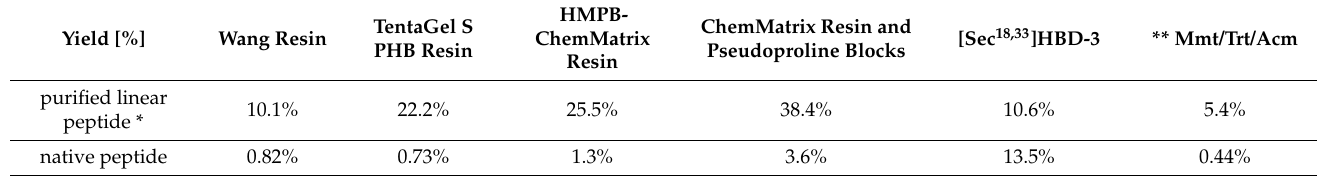
Figure 2. RP-HPLC traces of crude, linear precursor of HBD-3 synthesized on various resins: Figure 2. RP ‐ HPLC traces of crude, linear precursor of HBD ‐ 3 synthesized on various resins: ( A ) ( A ) HBD-3 synthesized on Fmoc-Lys(Boc)-TentaGel S PHB resin; ( B ) HBD-3 synthesized on Fmoc- HBD ‐ 3 synthesized on Fmoc ‐ Lys(Boc) ‐ TentaGel S PHB resin; ( B ) HBD ‐ 3 synthesized on Fmoc ‐ Lys(Boc)-Wang resin; ( C ) HBD-3 synthesized on Fmoc-Lys(Boc)-HMPB-ChemMatrix; ( D ) HBD-3 Lys(Boc) ‐ Wang resin; ( C ) HBD ‐ 3 synthesized on Fmoc ‐ Lys(Boc) ‐ HMPB ‐ ChemMatrix ; ( D ) HBD ‐ 3 synthesized on Fmoc-Lys(Boc)-HMPB-ChemMatrix and with three pseudoproline building blocks; synthesized on Fmoc ‐ Lys(Boc) ‐ HMPB ‐ ChemMatrix and with three pseudoproline building blocks; The asterisk indicates the linear HBD-3 in the crude material. Table 1. The yield of chemical synthesis and oxidative folding of HBD-3 and [Sec 18,33 ]HBD-3 under Table 1. The yield of chemical synthesis and oxidative folding of HBD ‐ 3 and [Sec 18,33 ]HBD ‐ 3 under different different conditions.